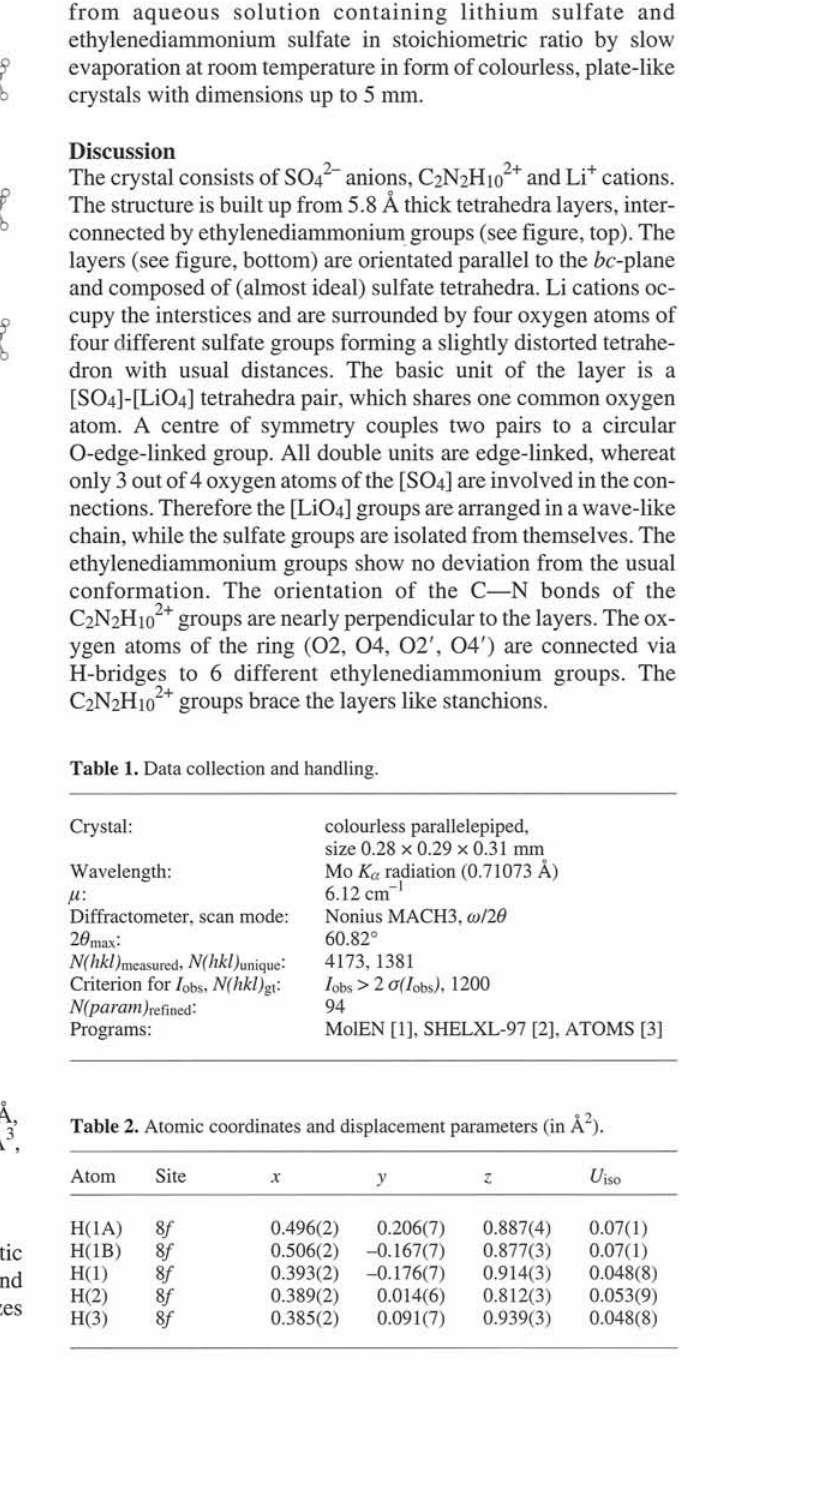
Table 2. Atomic coordinates and displacement parameters (in Â 2